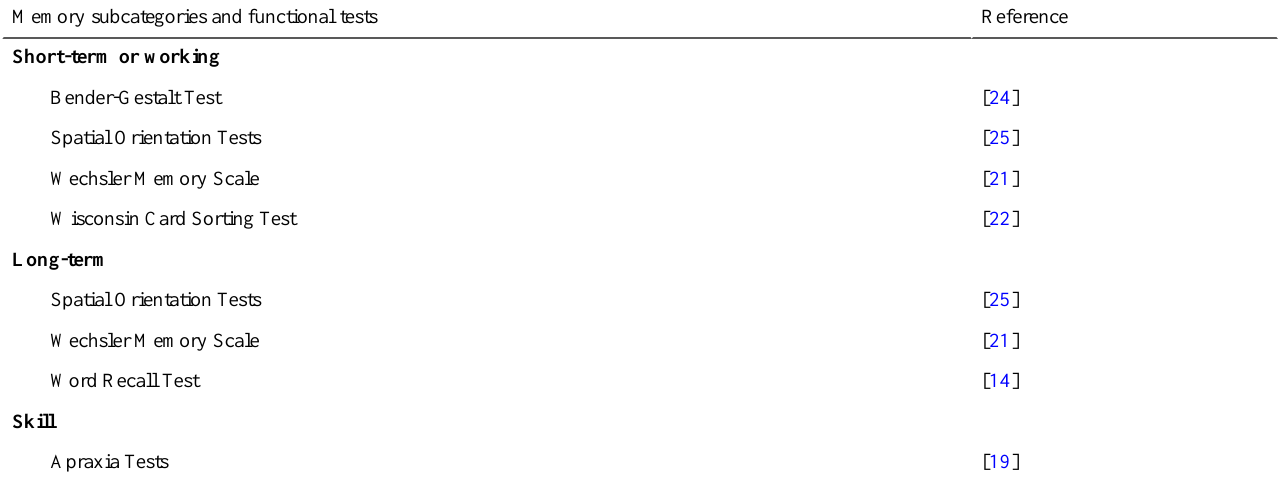
Table 6. Memory functional tests and assessment